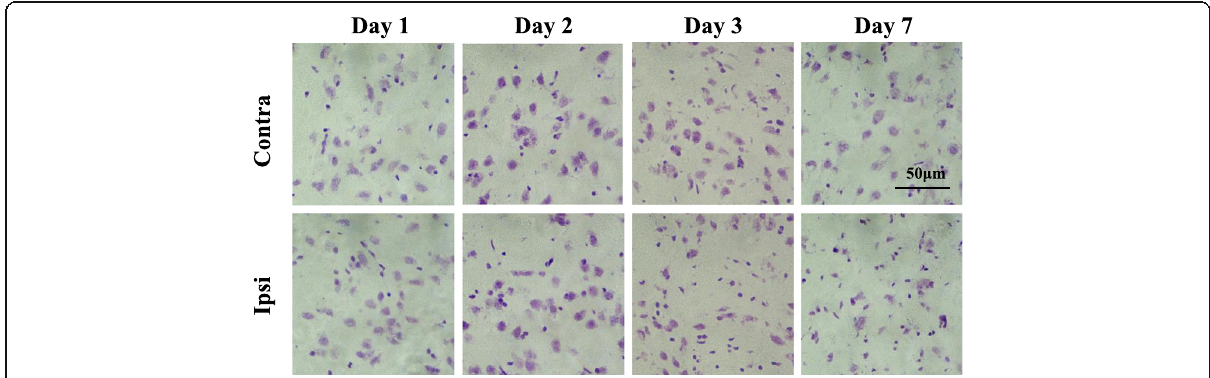
Fig. 3 Typical Nissl staining images in the dorsal striatum after mild focal ischemia. The upper panels are the images of contralateral side striatum, and the bottom panels are the images of ipsilateral side striatum at 1, 2, 3, and 7 days after 20-min middle cerebral artery occlusion (MCAO). Scale bar, 50 μ m. Contra, contralateral side; Ipsi, ipsilateral